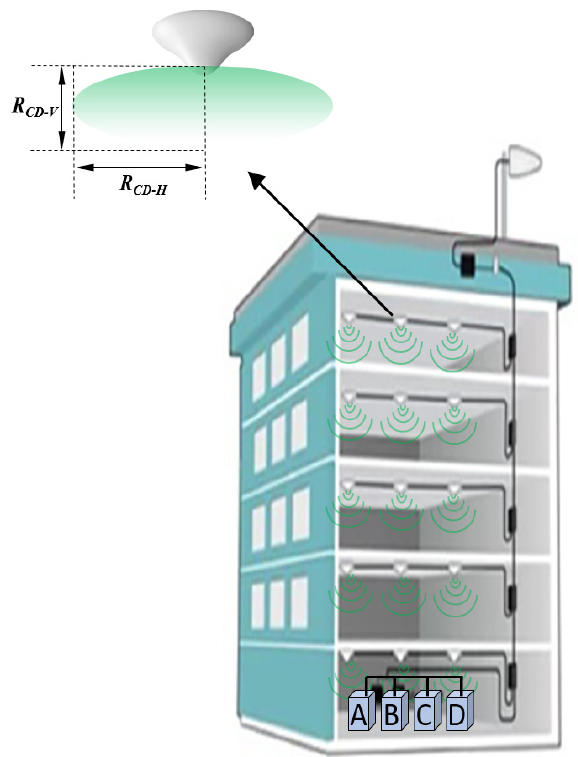
Figure 10. The horizontal R CD-H and vertical R CD-V compliance distances for one IBS-DAS antenna installed on the ceiling of a building floor for IBS shared by 4 operators (A, B, C, and D).